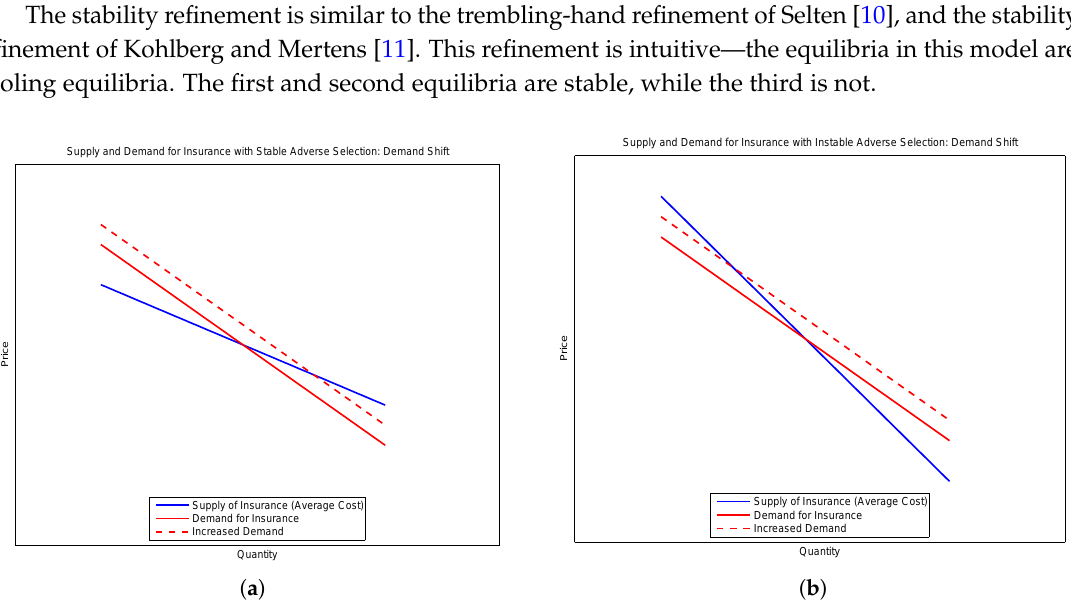
Figure 1. Supply and demand for insurance with asymmetric information and changes in